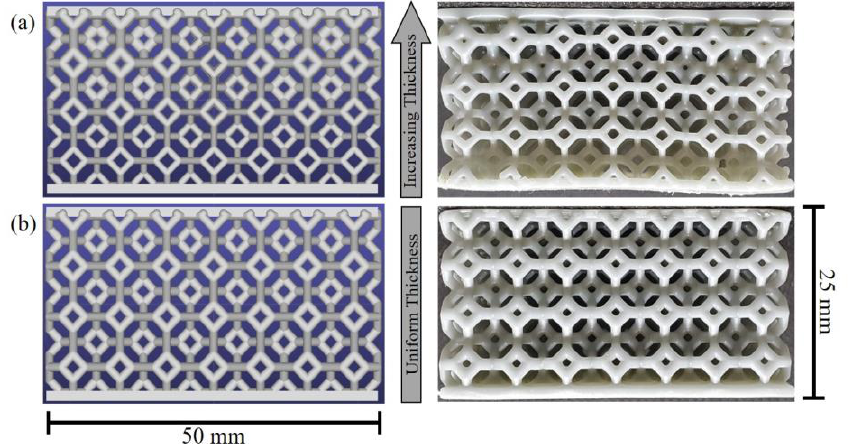
Figure 1. Rendering and photos of the lattice structures investigated in this work based on the Kelvin